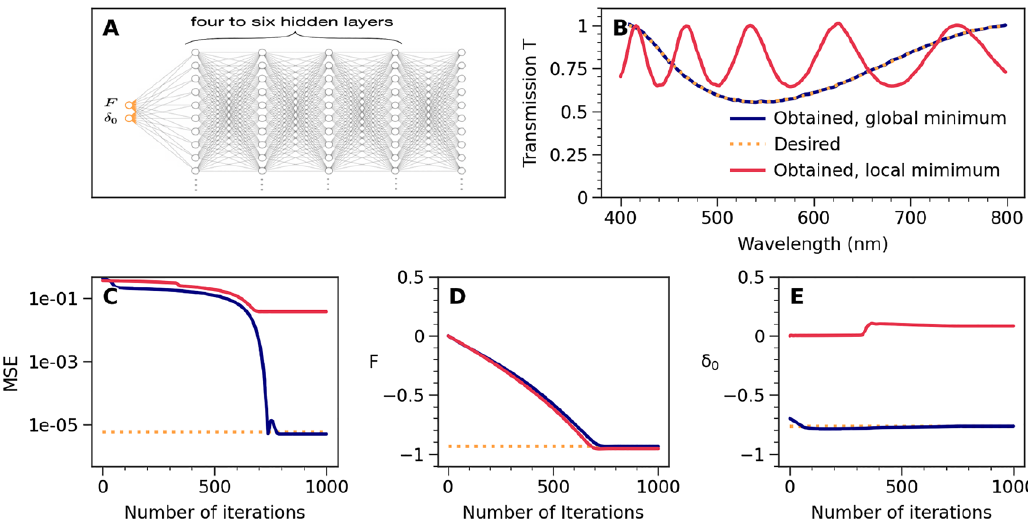
Figure 2: The second step of inverse design using deep learning. (A) A trained neural network mapping the resonator parameters F and δ 0 to the wavelength-dependent transmission. Only the resonator parameters (the input nodes, in orange) are updated. (B) Example of a desired spectrum and spectra obtained through inverse design. The desired transmission is shown in orange and the transmission predicted by the trained neural network for the obtained resonator parameters is shown in blue and red. Two sets of resonator parameters are obtained for different initializations of the input parameters F and δ 0 . (C) Evolution of the loss function during training. (D) Evolution of F during training. The orange line shows the value of F used to create the desired transmission. Values are normalized between − 1 and 1. (E) Evolution of δ 0 during training. The orange line shows the value of δ 0 to create the desired loss function, the mean squared error (MSE) on the Fourier power spectrum of the target function T ( λ ), given by